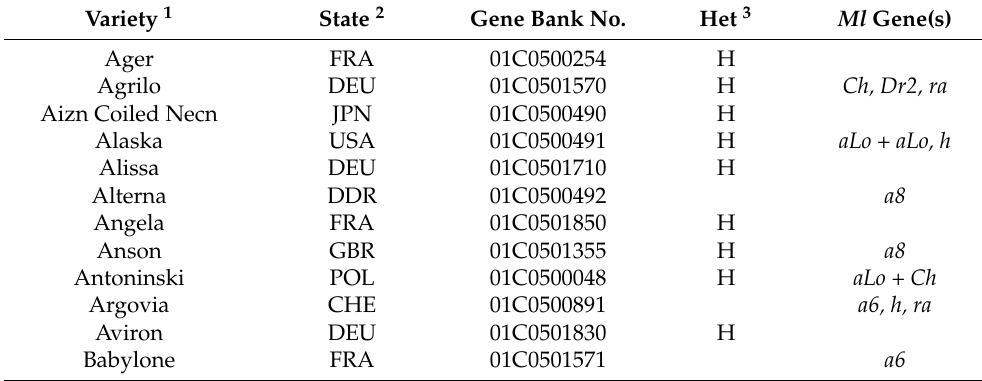
Table 2. Specific resistance genes against Blumeria graminis f. sp. hordei in 172 accessions of the